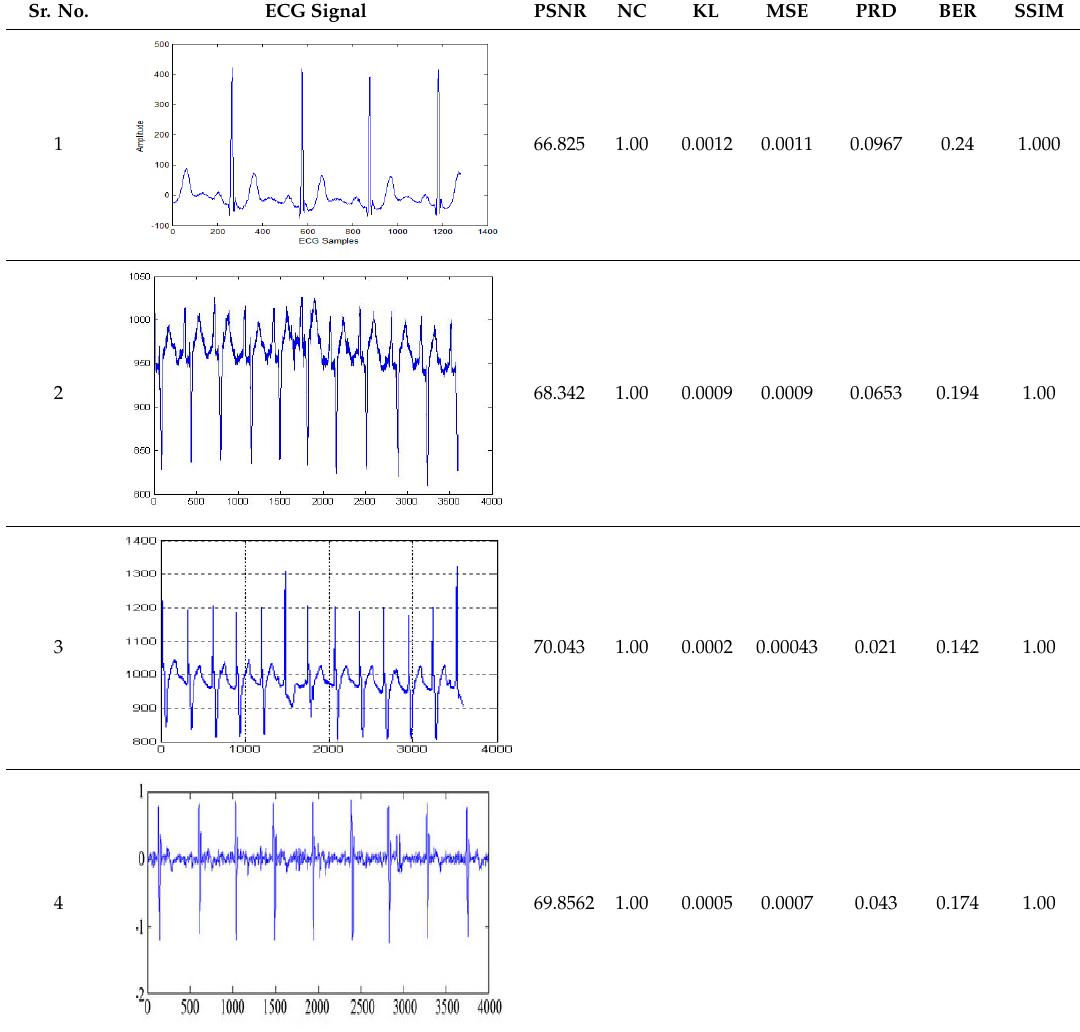
Table 1. Performance of proposed techniques (Peak signal to noise ratio (PSNR),Normalized correlation (NC), Kullback–Leibler divergence (KL),Mean Square Error(MSE),Percentage residual difference (PRD),Bit error rate (BER),,Structure similarity index measure (SSIM). Sr. No.